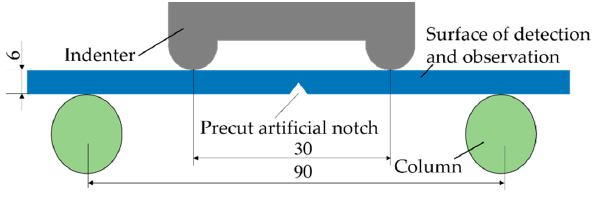
Figure 2. Schematic diagram of the load (Unit: mm).